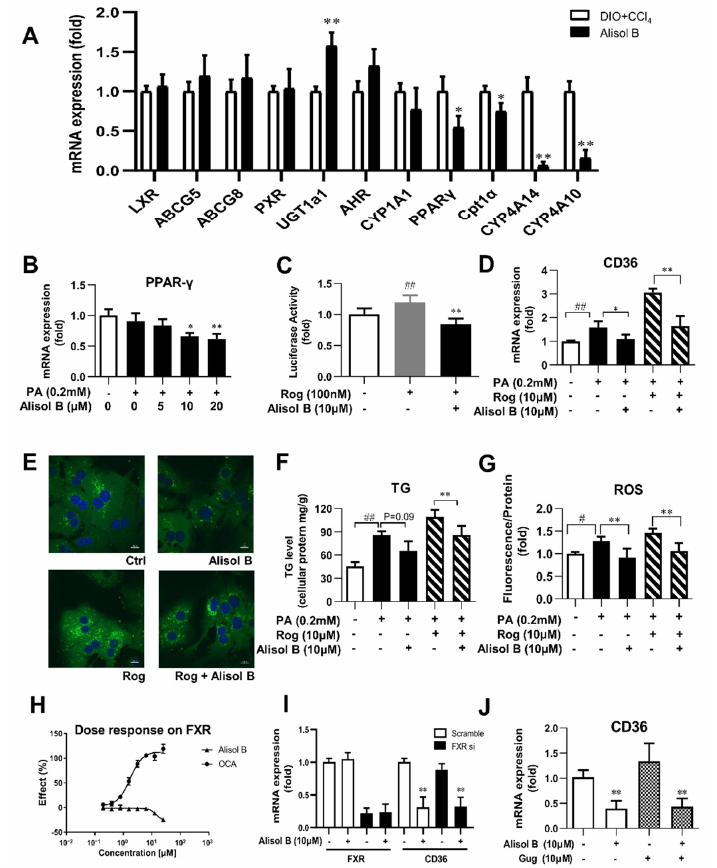
Figure 6. Alisol B suppressed CD36 expression through downregulating PPAR γ , and this effect was independent of FXR. ( A ) The mRNA expression of hepatic LXR, PXR, AHR, PPAR γ , and their